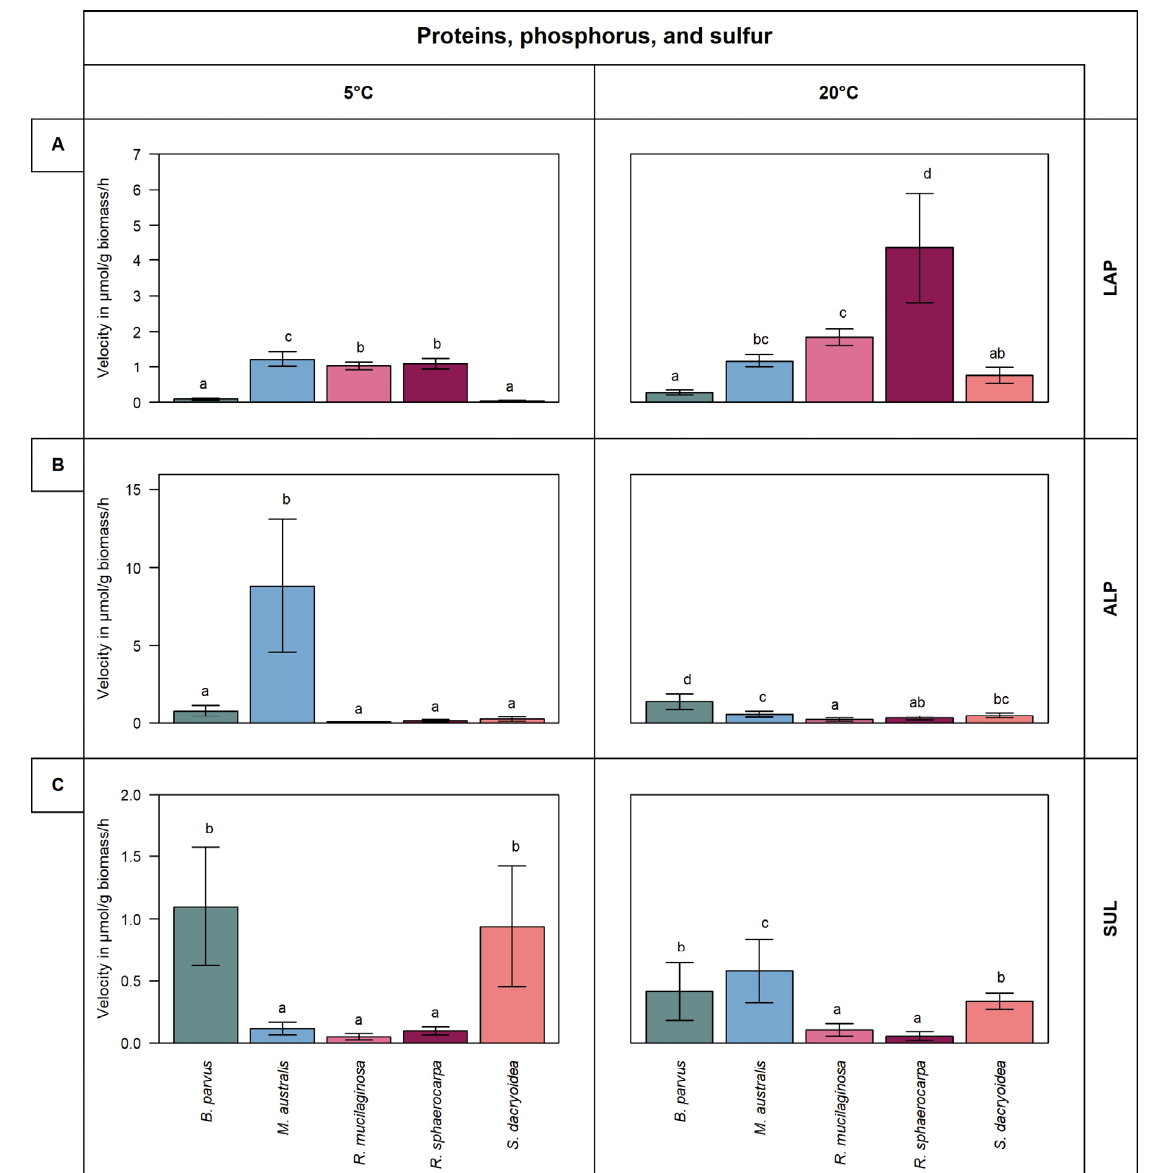
Figure 2. V max in µ mol/g biomass/h obtained from the total enzymatic activity for the substrates representing proteins, phosphorus, and sulfur, such as ( A ) leucine aminopeptidase (LAP), ( B ) alkaline phosphatase (ALP), and ( C ) sulfatase (SUL) of the five marine fungal isolates B. parvus , M. australis , R. mucilaginosa , R. sphaerocarpa , and S. dacryoidea at 5 ◦ C and 20 ◦ C. According to Tukey’s HSD, bars denoted by a different letter (a, b, c, and d) are significantly different ( p < 0.05), whereas bars denoted by a common letter (ab and bc) are not significantly